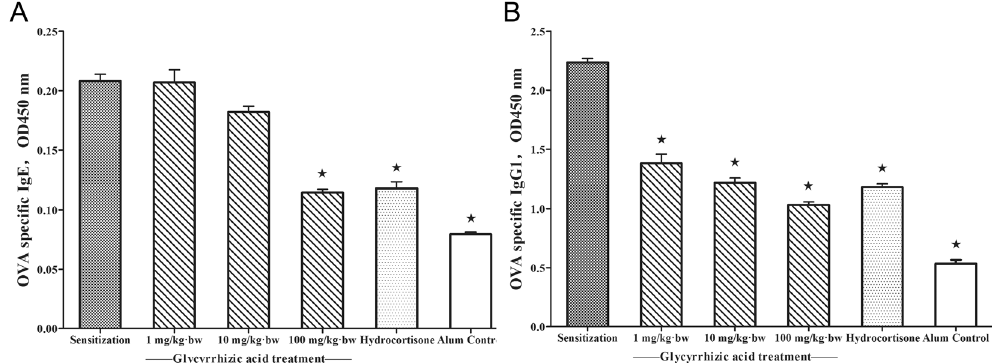
Figure 3. GA inhibited the production of OVA-specific IgE and IgG 1 from B cells. * P < 0.05 as compared to the sensitization group (n = 5). The level of OVA-specific ( A ) IgE and ( B ) IgG 1 in serum.